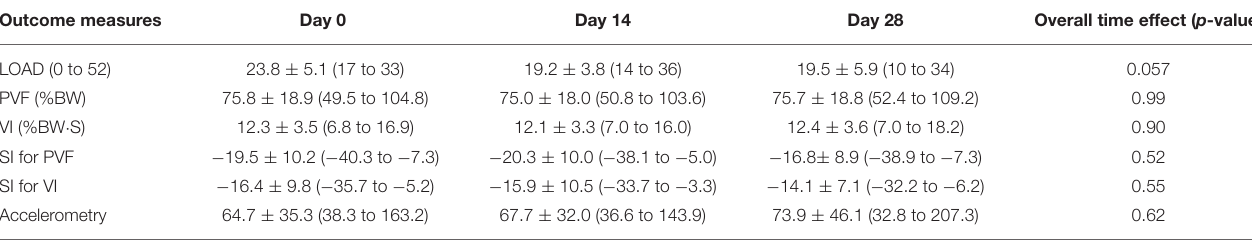
TABLE 3a | Outcome measure values at each time point in Part A of the study (mean ± SD and range). Outcome measures